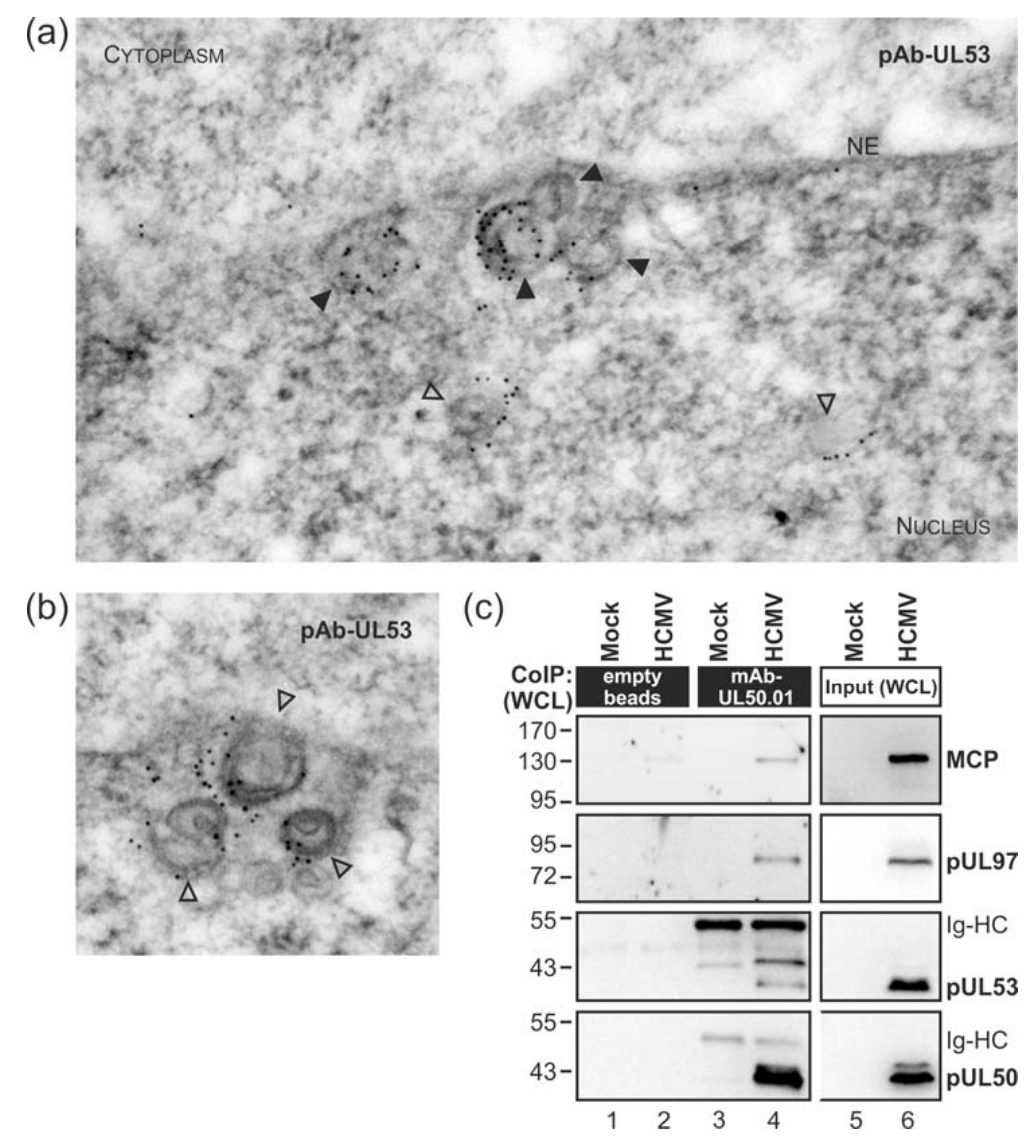
Figure 1. Association of the viral core nuclear egress complex (NEC) constituent pUL53 with intranuclear human cytomegalovirus (HCMV) capsids and capsids budding at the inner nuclear membrane (INM). ( a , b ) HCMV-infected primary human foreskin fibroblasts (HFFs) were harvested at 3 dpi and subjected to immunogold staining of viral pUL53. Samples were analysed by transmission electron microscopy (TEM), 35,970-fold magnification. NE, nuclear envelope; open arrowheads, intranuclear HCMV capsids; filled arrowheads, HCMV capsids budding at nuclear membranes; ( c ) Co-immunoprecipitation (CoIP) analysis with HCMV-infected whole cell lysates (WCL). HCMV- or uninfected (mock)-HFFs were lysed at 4 dpi followed by immunoprecipitation with monoclonal antibody (mAb)-UL50.01 coupled to protein A sepharose (lanes 3–4) or empty beads as a CoIP negative control (lanes 1–2). CoIP samples (lanes 1–4) and expression control samples (input, representing one-twentieth of CoIP samples; lanes 5–6) were subjected to Western blot analysis using protein-specific antibodies. Ig-HC, cross-reactive band for immunoglobulin heavy chain; MCP, major capsid protein.